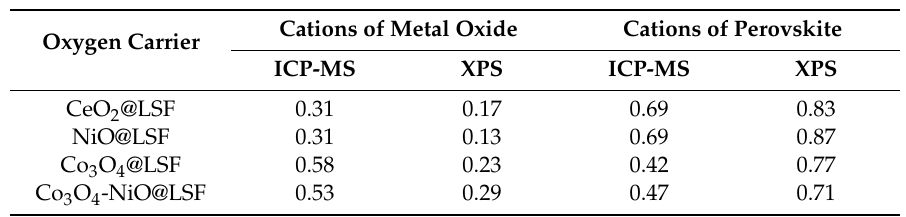
Table 1. Cation compositions measured by inductively coupled plasma mass spectroscopy (ICP-MS) and